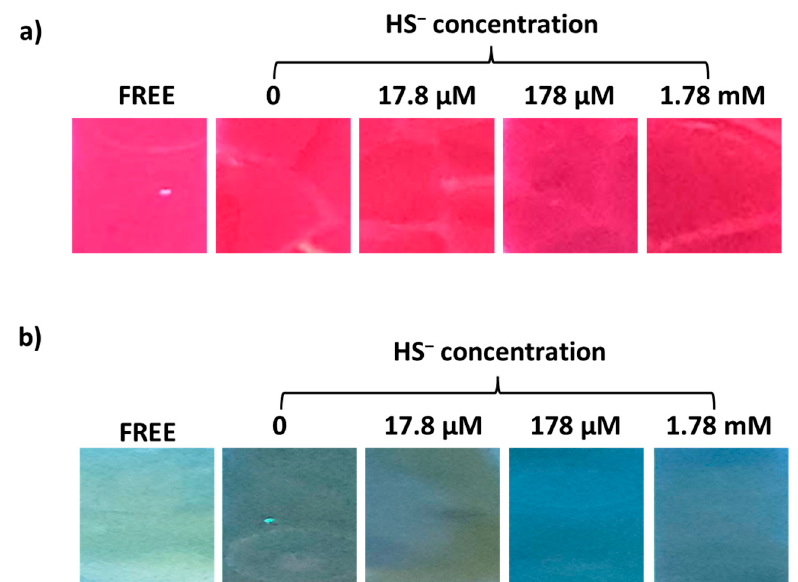
Figure 7. Real color images of a cropped area of the model complex—reported in Figure 5—( a ) and complex 1 ( b ) loaded in sol-gel matrices after adding increasing amounts of HS − dissolved in HBSS (0, 17.8 μ M, 178 μ M, and 1.78 mM). Non-treated matrices are indicated as FREE.